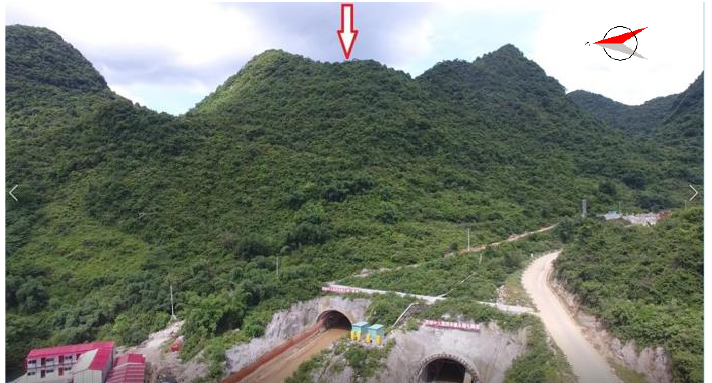
Figure 2. Tunnel top position of water inrush section. (The arrow indicates the location of the karst cave).